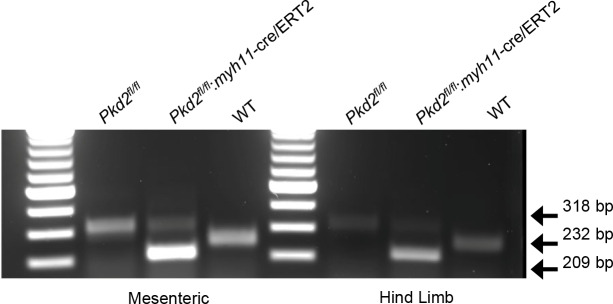
Genotyping of mouse lines.Ethidium bromide gel illustrating PCR products in vasculature of C57BL/6J (WT) mice and tamoxifen-treated Pkd2fl/fl and Pkd2fl/fl:myh11cre/ERT2 mice.